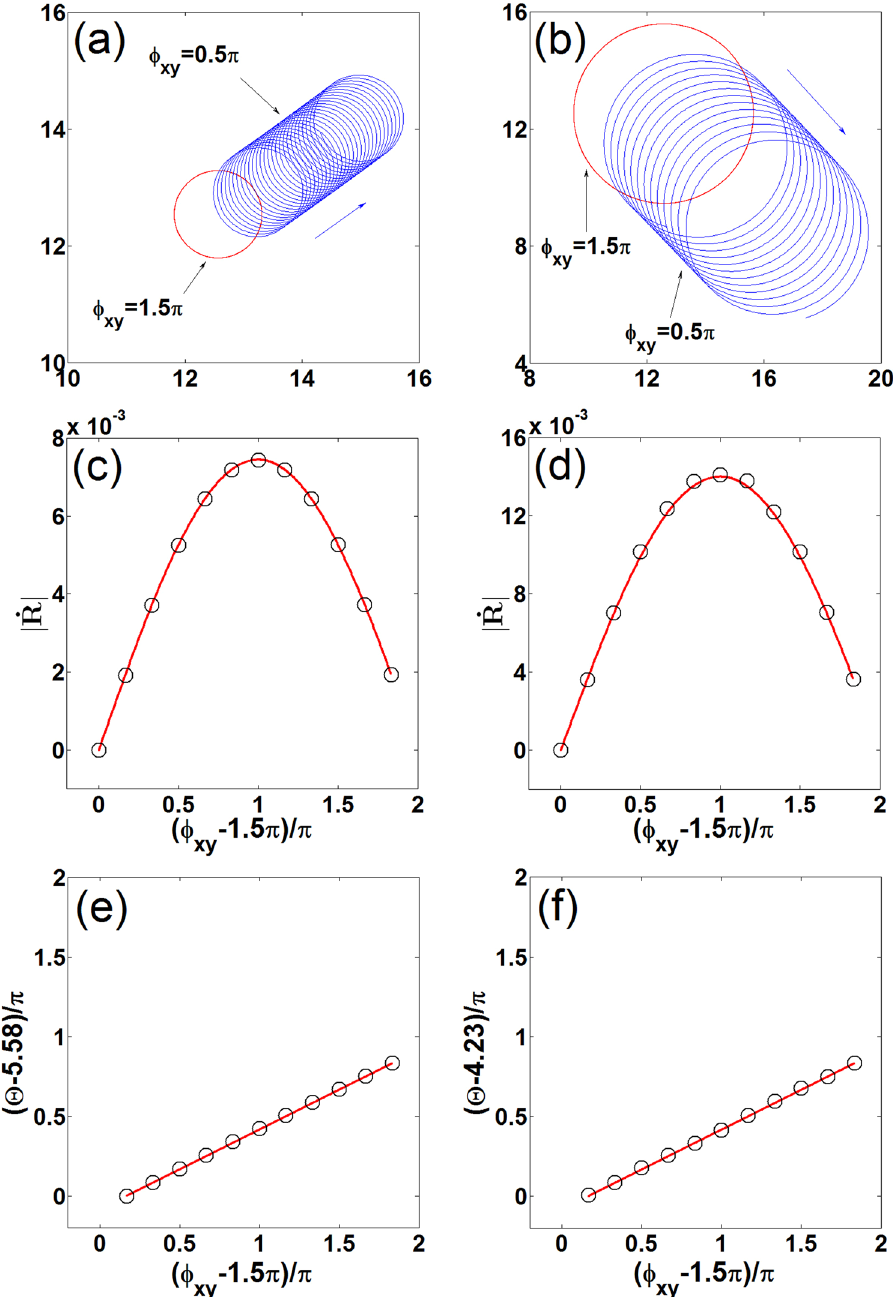
Figure 4. First row: Drifting behaviors of spirals under the influence of a clockwise ( φ xy = 0.5 π ) and a counterclockwise ( φ xy = 1.5 π ) circularly polarized electric fields with ω e = 2 ω , φ e = 0, and Φ = 0. Second row: Dependence of theoretical (lines) and numerical (circles) drift speed on φ xy with φ e = 0 and Φ = 0. Third row: Dependence of theoretical (lines) and numerical (circles) drift angle on φ xy with φ e = 0 and Φ = 0. When the drift speed is 0 ( φ xy = 1.5 π ), the drift angle cannot be defined. Left column: Highly excitable medium. Right column: Weakly excitable